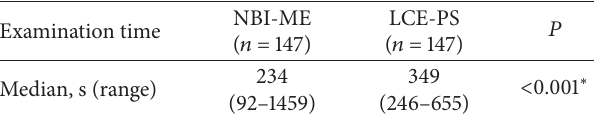
Table 6: Comparison of examination times between NBI-ME and LCE-PS (Per-protocol